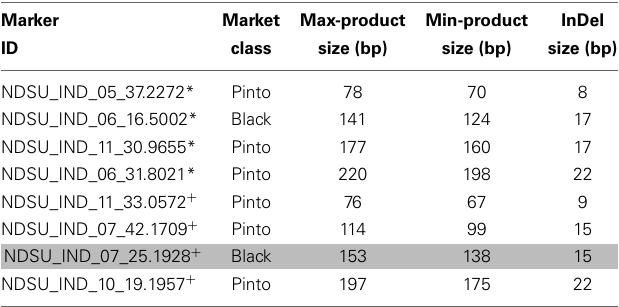
Table 8 | Specifications of InDel markers used for multiplexing (two sets of